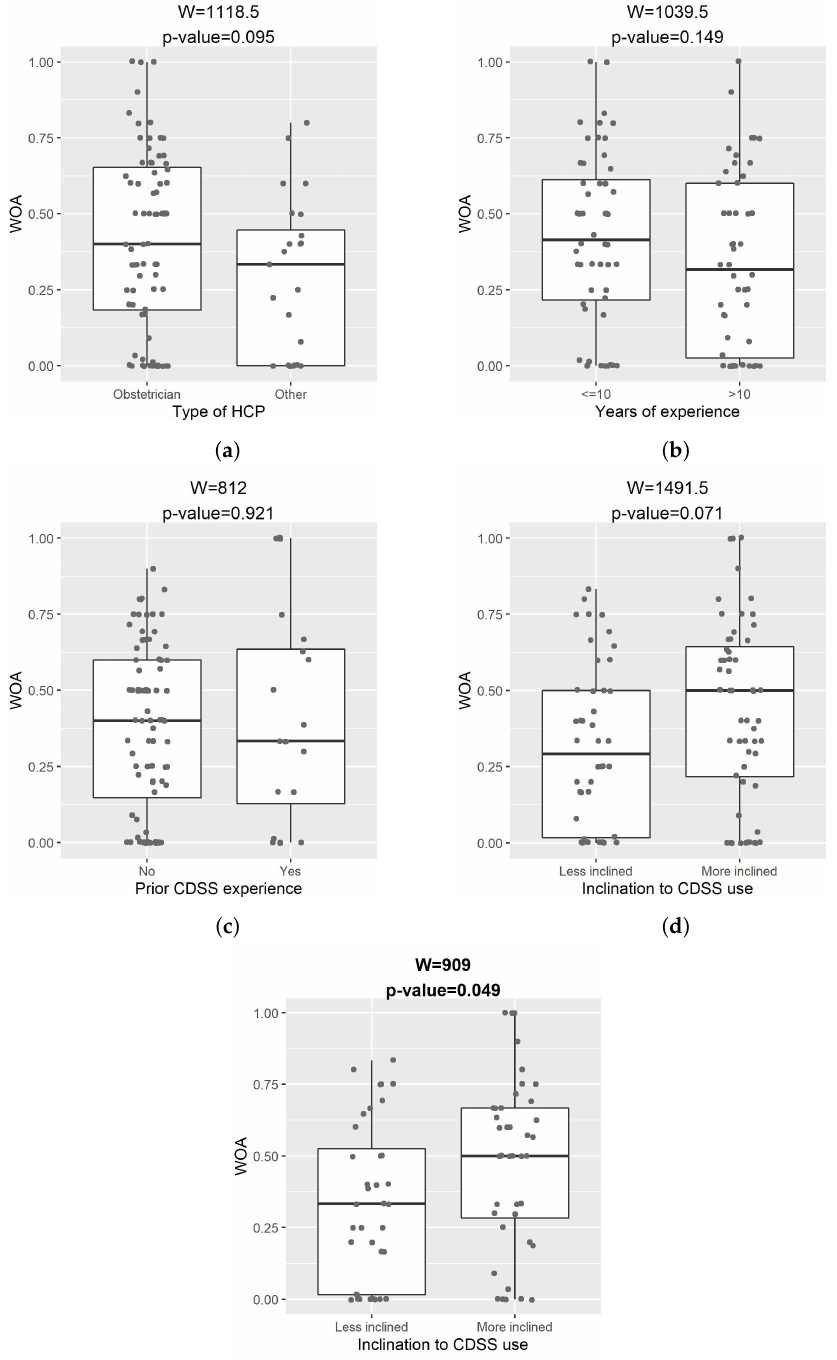
Figure 8. Comparison of the overall WOA of an explainable CDSS between subgroups of participants. ( a ) Comparison between obstetricians and other HCPs (midwives and dietitians). ( b ) Comparison between HCPs with (cid:54) and >10 years of experience. ( c ) Comparison between HCPs with and without prior experience of CDSS use. ( d ) Comparison between all HCPs who were less and more inclined to CDSS use. ( e ) Comparison between obstetricians who were less and more inclined to CDSS use. Significant differences are highlighted in bold. HCP: healthcare